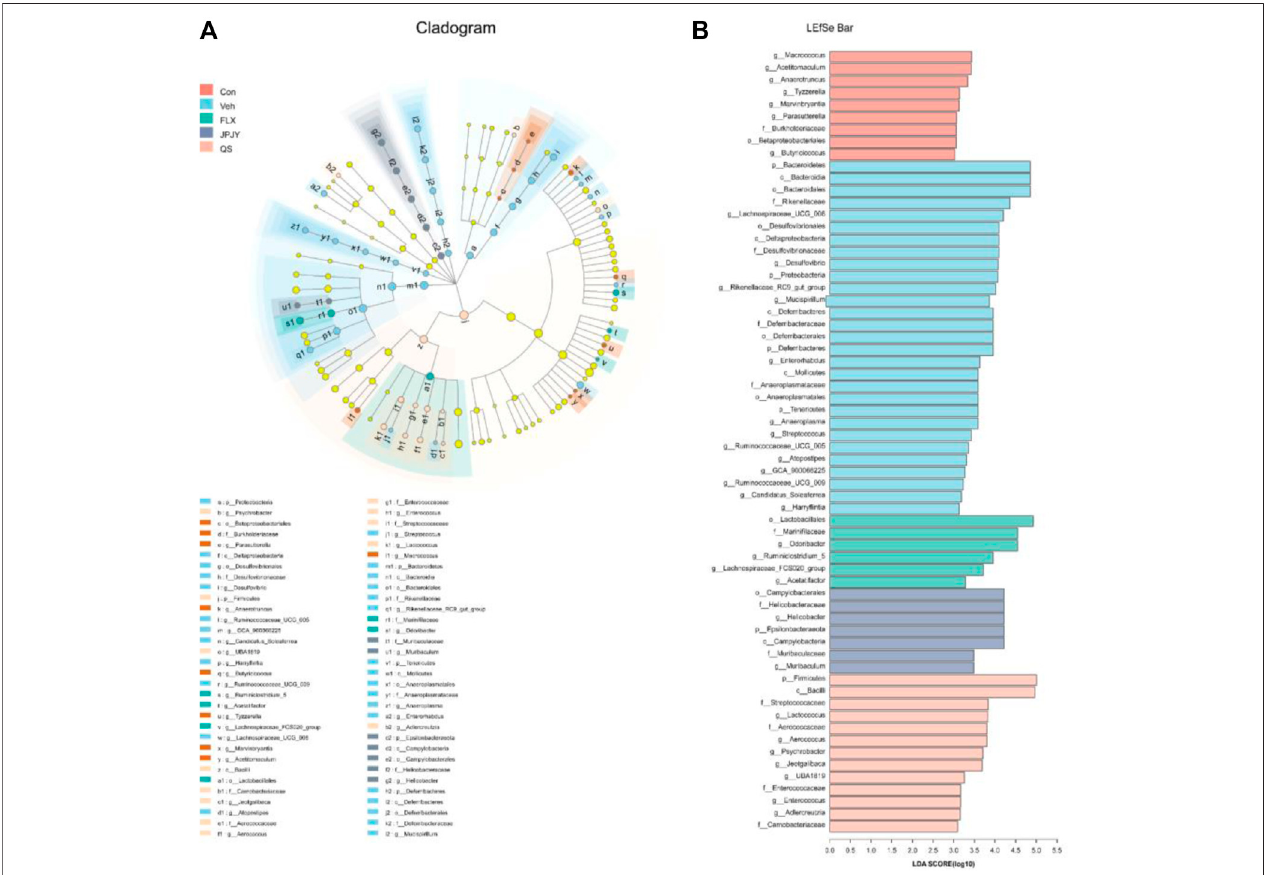
FIGURE5| Analysisofgutmicrobiotafollowingdrugtreatment. (A) CladogramfortaxonomygeneratedthroughLEfSeanalysisshowingprominentshiftsinthegut microbiota in each group (score > 3). (B) Linear discriminant analysis (LDA) scores (log10) of taxa (score > 3).